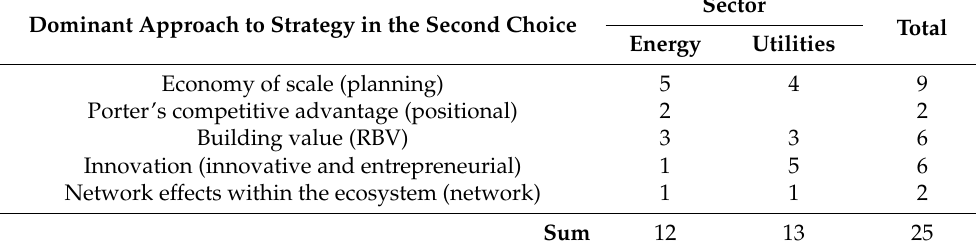
Table 7. Approach to the companies’ strategy in the second choice.